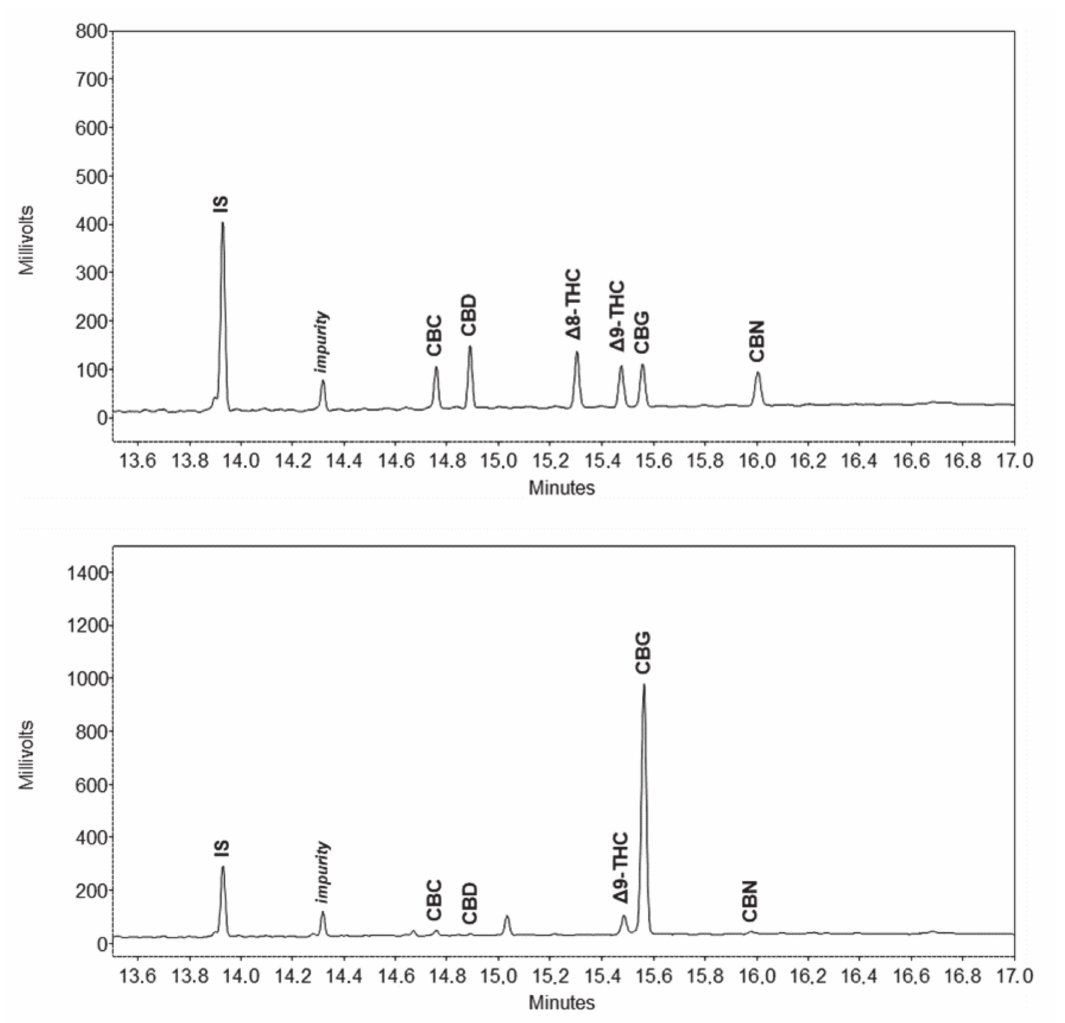
Figure 1. Chromatograms (displayed tR = 13.5–17.0 min) of cannabinoid standard solution ( top ) and hemp plant (cannabigerol (CBG) chemotype) extract ( bottom ). Peak labelling: IS—internal